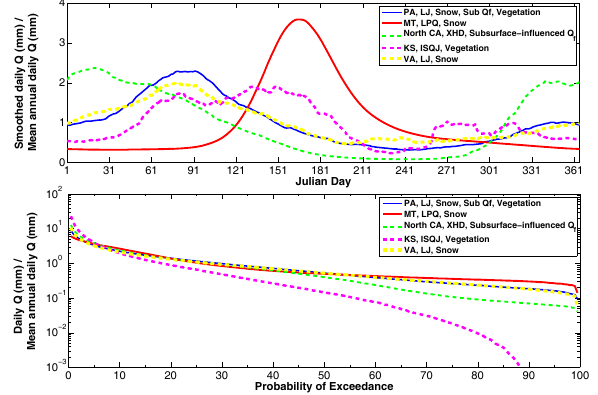
Fig. 13. Relationship between the slope of the FDC and the slope of the RC when plotted as an FDC (grouped by catchment class). A 1:1 line is provided for